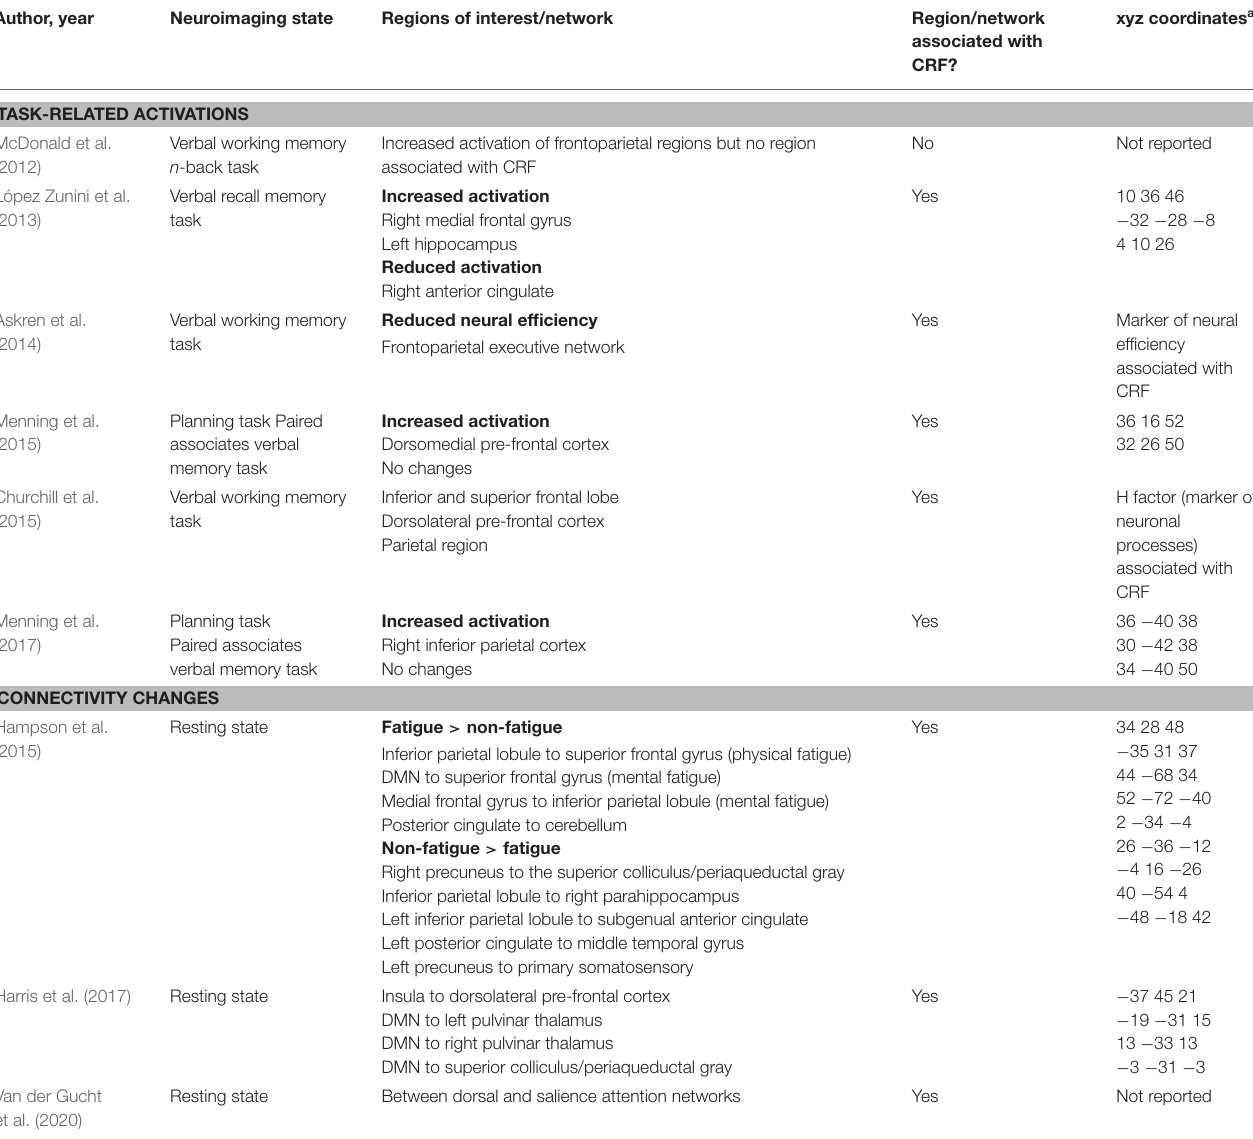
TABLE 3 | Brain regions and networks associated with breast cancer related fatigue. Author,